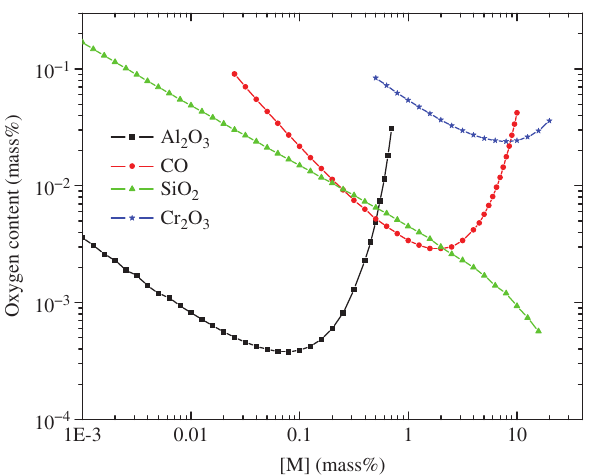
Figure 1: Deoxidation equilibrium curve of different elements in iron melt at 1,873 K.